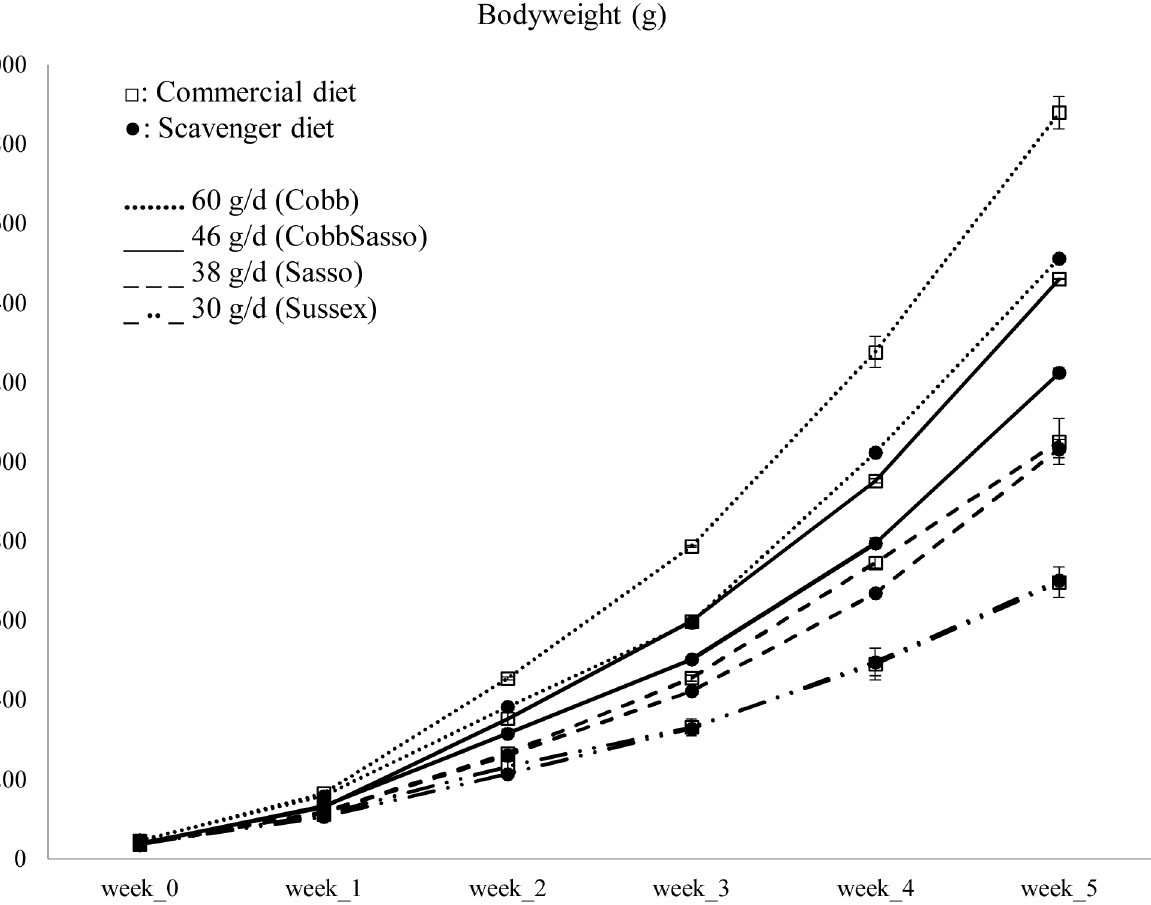
Fig 1. Bodyweight ( ± standard deviation) of four chicken breeds, each with its breed-specific growth rate, fed either a commercial or a scavenger diet.